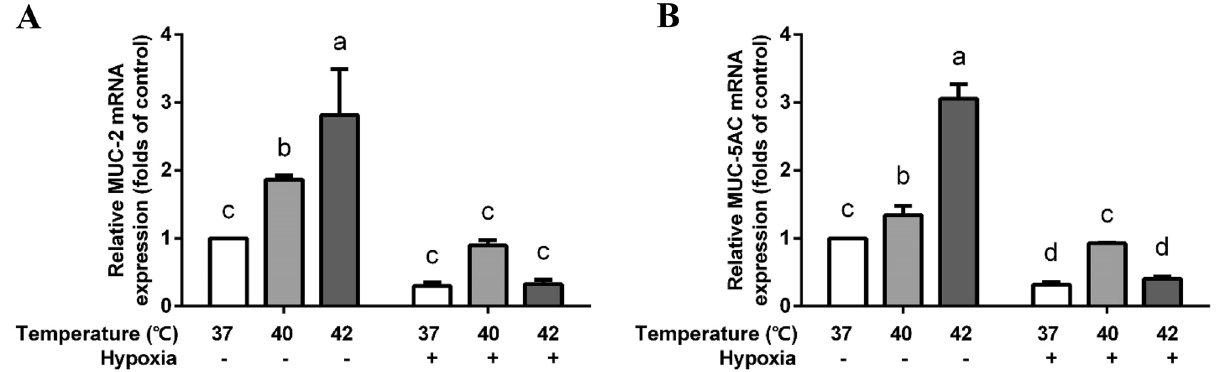
Figure 6. Effects of hypoxia and/or heat treatment on mucin gene production in the co-culture model. MUC-2 ( A ) and MUC-5AC ( B ) mRNA levels were assessed by qRT-PCR and normalized to the housekeeping gene β-actin. All values were presented as means ± SD (N = 3, n = 3). Statistical differences were analyzed by two- way ANOVA followed by the Bonferroni’s multiple comparison test. Means without a common letter differ at p <